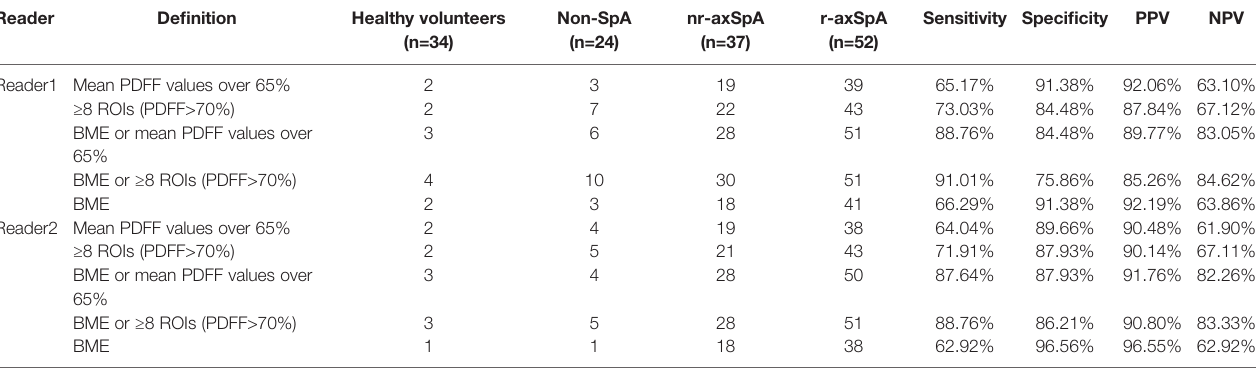
TABLE 5 | Sensitivities and speci fi cities of the 5 candidate de fi nitions of a positive SIJ MRI in all the study